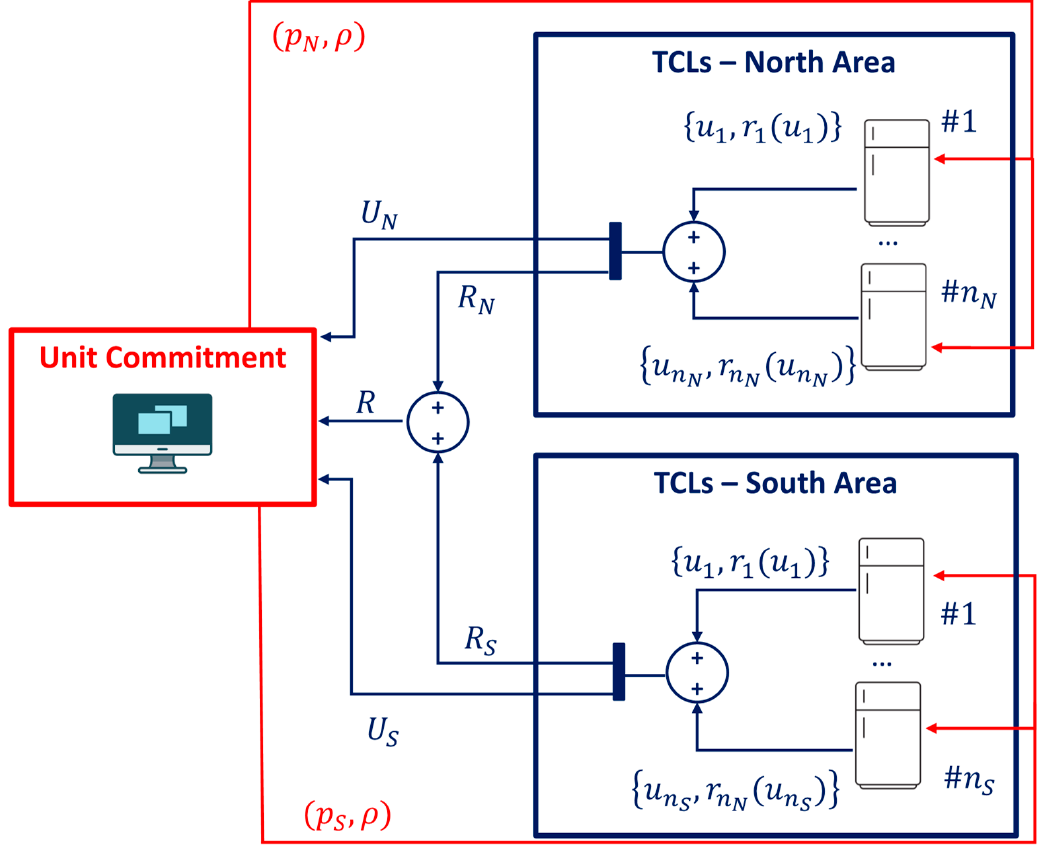
Figure 2. Diagram of the interactions between the Thermostatically Controlled Loads (TCLs) at each area and the unit commitment.